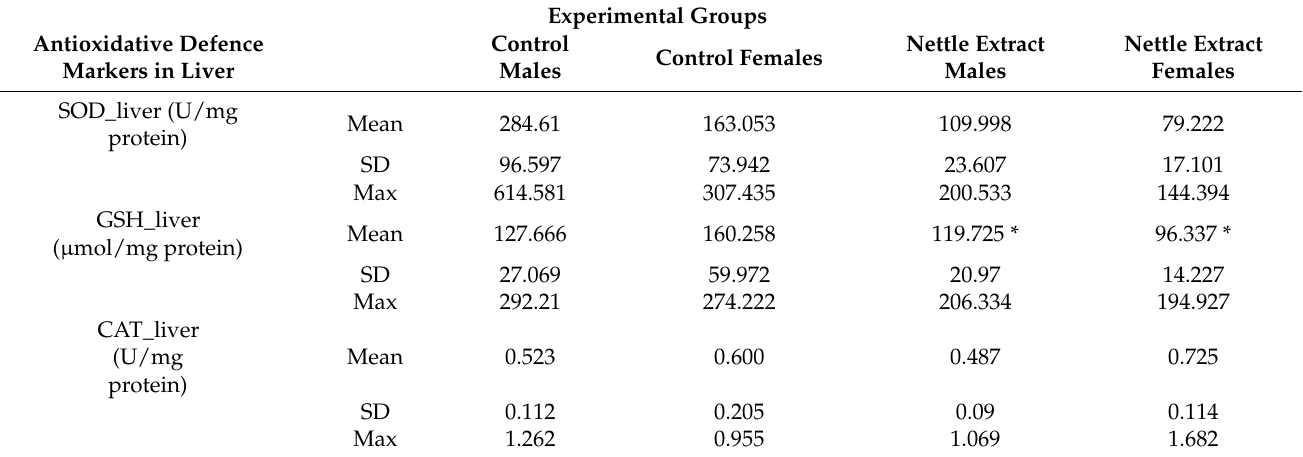
Table 1. ThechangesinantioxidativedefensemarkersintheliverofC57Bl6micetreatedwithnettleextract. Table 1. The changes in antioxidative defense markers in the liver of C57Bl6 mice treated with nettle extract. Experimental